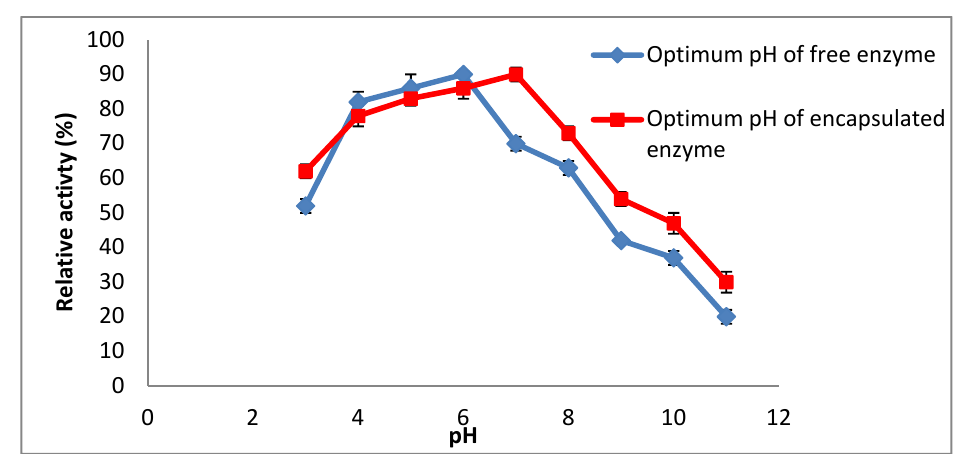
Figure 2. Optimum enzyme activity over wide range of